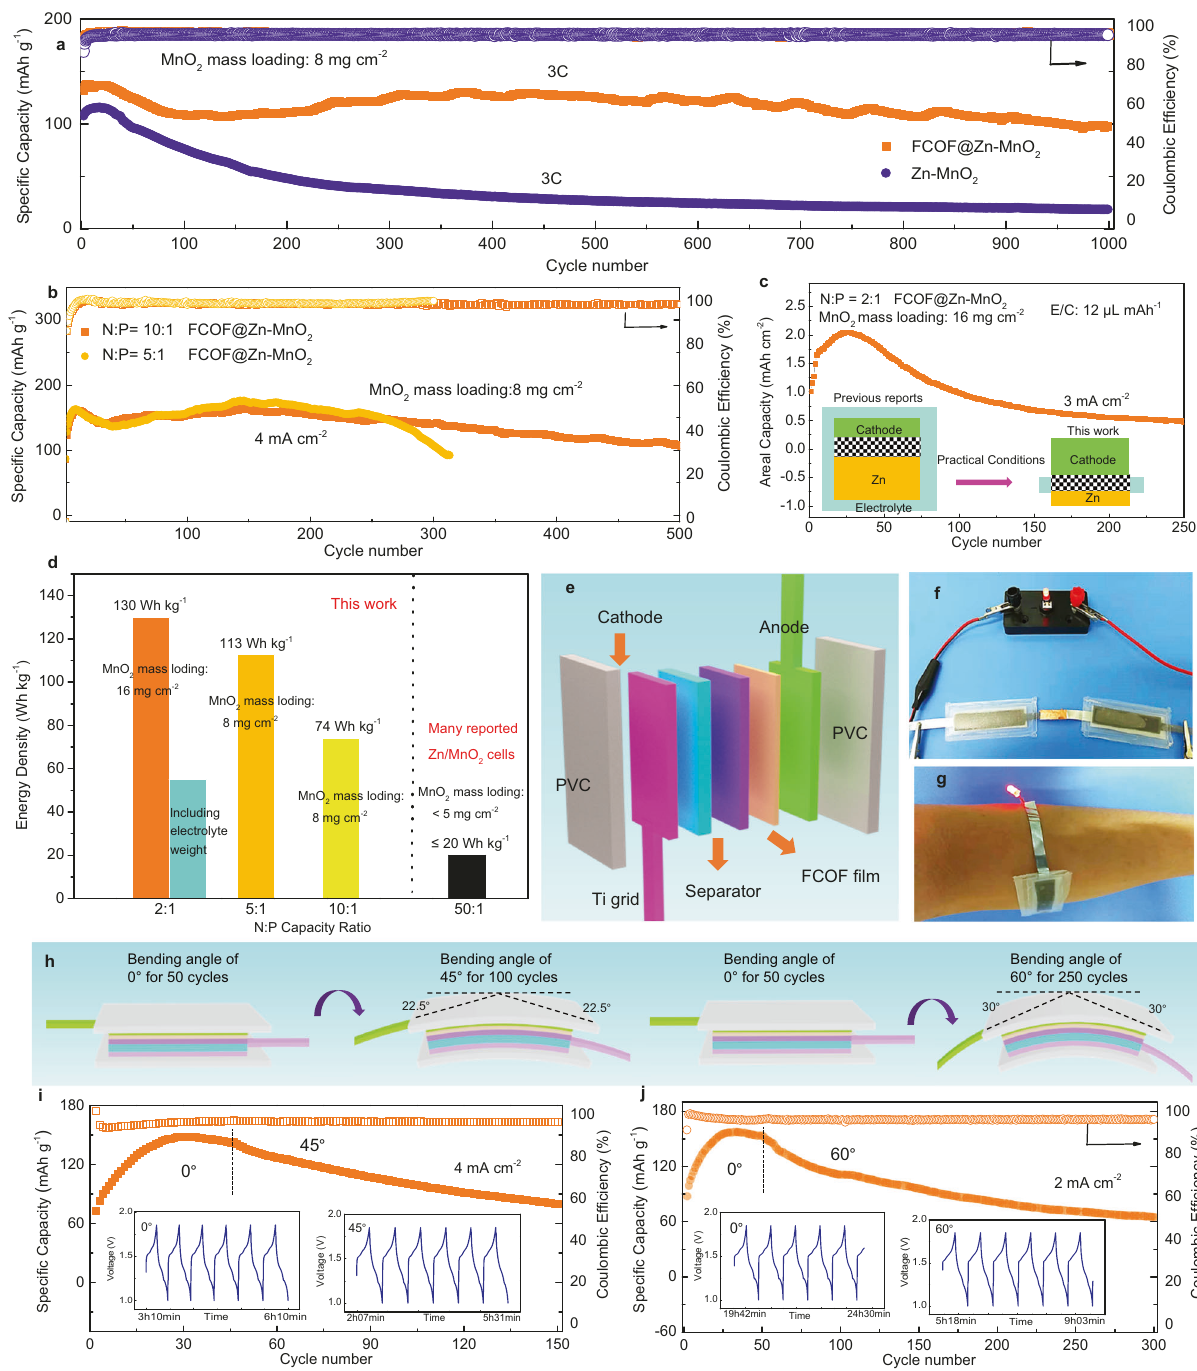
Fig. 5 The full cell performance and fl exible device demonstration. a Cycling performance at current density of 3 C. b Cycling performance at N : P capacity ratio conditions of 10:1 and 5:1. c Cycling performance at low N : P capacity ratio of 2:1 with controlled electrolyte addition of 12 μ L mAh − 1 d Dependence of cell-level energy density on N / P ratio in Zn/MnO 2 full cell. The gravimetrical energy density is calculated based on the total mass of the Zn anode and the MnO 2 cathode. e Assembly schematic illustration of the fl exible transparent battery. f , g Pictures of the battery acting as a source of energy to power a LED. h – j Cycling performance of the fl exible transparent battery under different bending angles. The insets are selected voltage-time pro fi